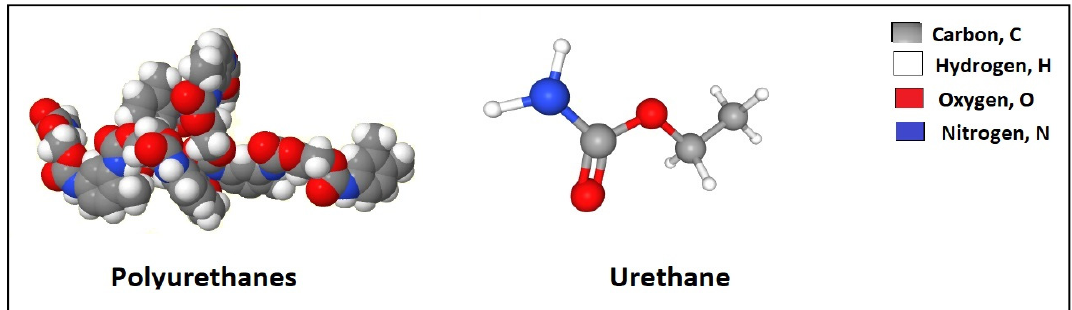
Figure 9. Chemical structure of polyurethanes and urethane.